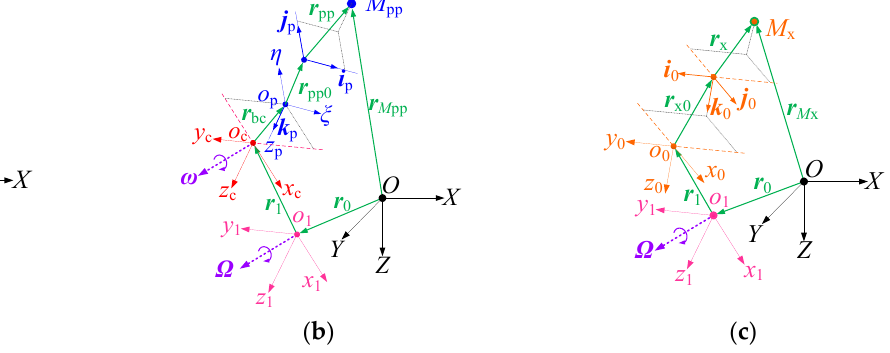
Figure 4. The coordinate system of the component nodes: ( a ) Sun gear node; ( b ) Pin node; ( c ) Casing node. ω represents the angular velocity of the coordinate system o c - x c y c z c around point o c , ω = ω c · k c , ω c denotes the speed of the planet carrier. Ω is the rotational angular velocity of the coordinate system o 1 - x 1 y 1 z 1 . The radius vector of point o 1 in the Earth coordinate system O - XYZ is r 0 , the radius vector of point o c in o 1 - x 1 y 1 z 1 is r 1 . r s0 = z s0 · k c denotes the initial radial vector caused by the distribution of the nodes of the sun gear shaft along its own axis, z s0 represents the coordinates of node M s relative to the origin o c , and the radius vector of point M s in O - XYZ is r M s . The pin shaft node M pp is located on the equivalent base circle of the planet carrier, and there is an initial vector radius r bc . Pin shaft nodes are distributed in the direction of their own axis o p z p , so the moving point M pp has an initial radial r pp0 similar to r s0 , and the radius vector of point M pp in O - XYZ is r M pp . Different from the central member, planet gear and pin, when inertial effects under maneuvering flight conditions are not considered, the DOF of the casing nodes are all